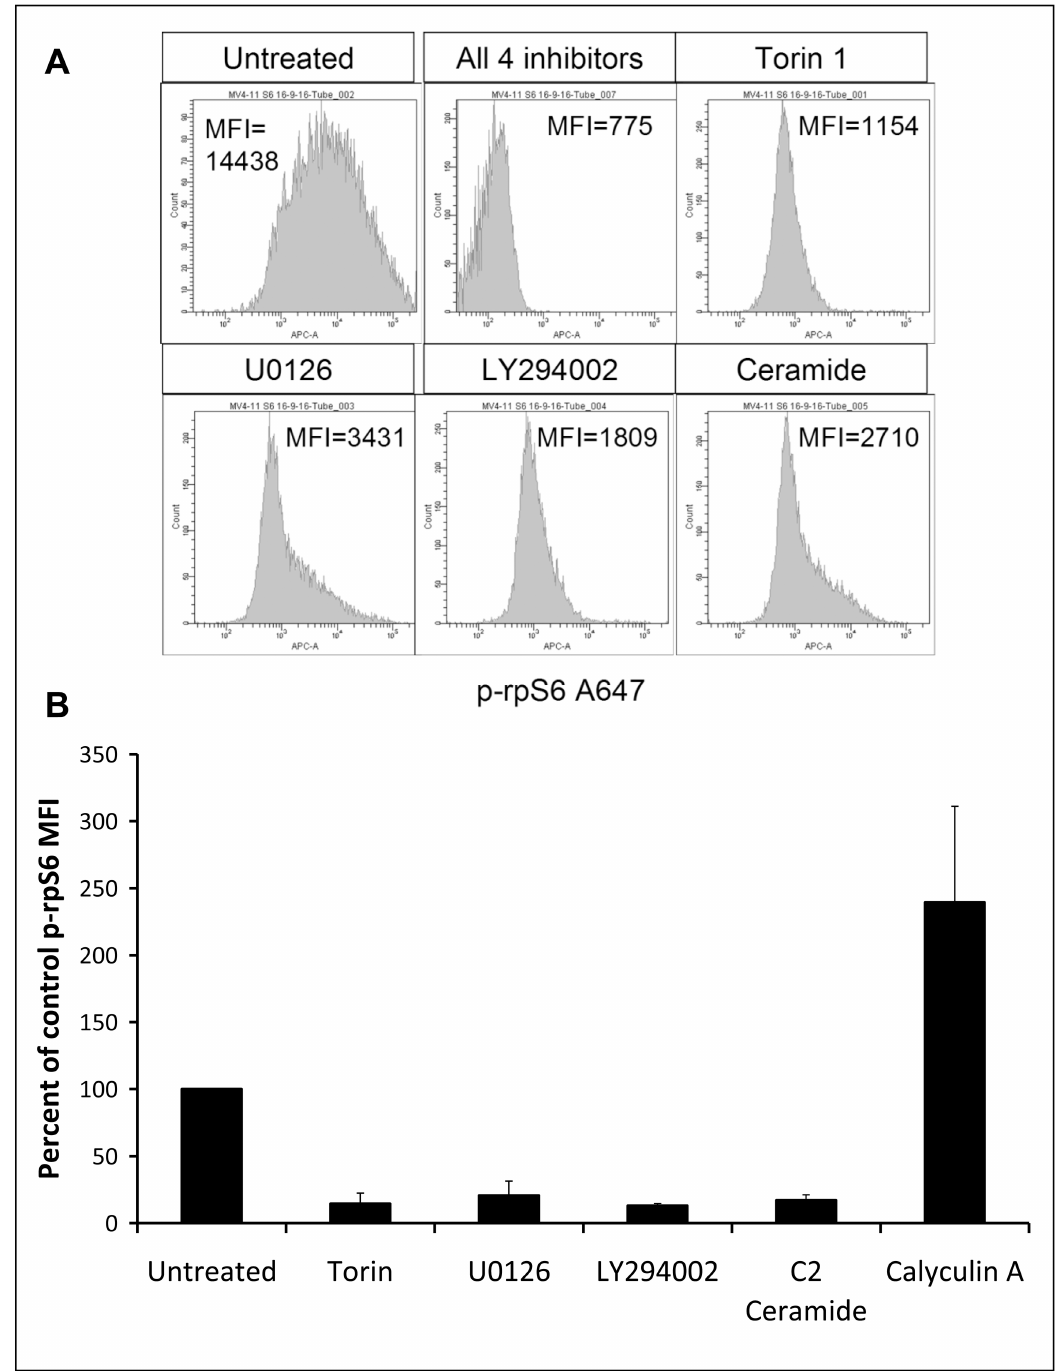
Fig 1. RpS6 dephosphorylation by signalling inhibitors. (A) MV4-11 cells were cultured for 4 hours with 1 μM torin1, 5 μM U0126, 30 μM LY294002, 30 μM C2-ceramide or a combination of all 4 inhibitors. (B) Values are a percent of untreated cell phospo-rpS6 as described in the methods. (Mean+/- SD for n = 3–5). The phosphatase inhibitor Calyculin A (3 nM) was used as positive control.